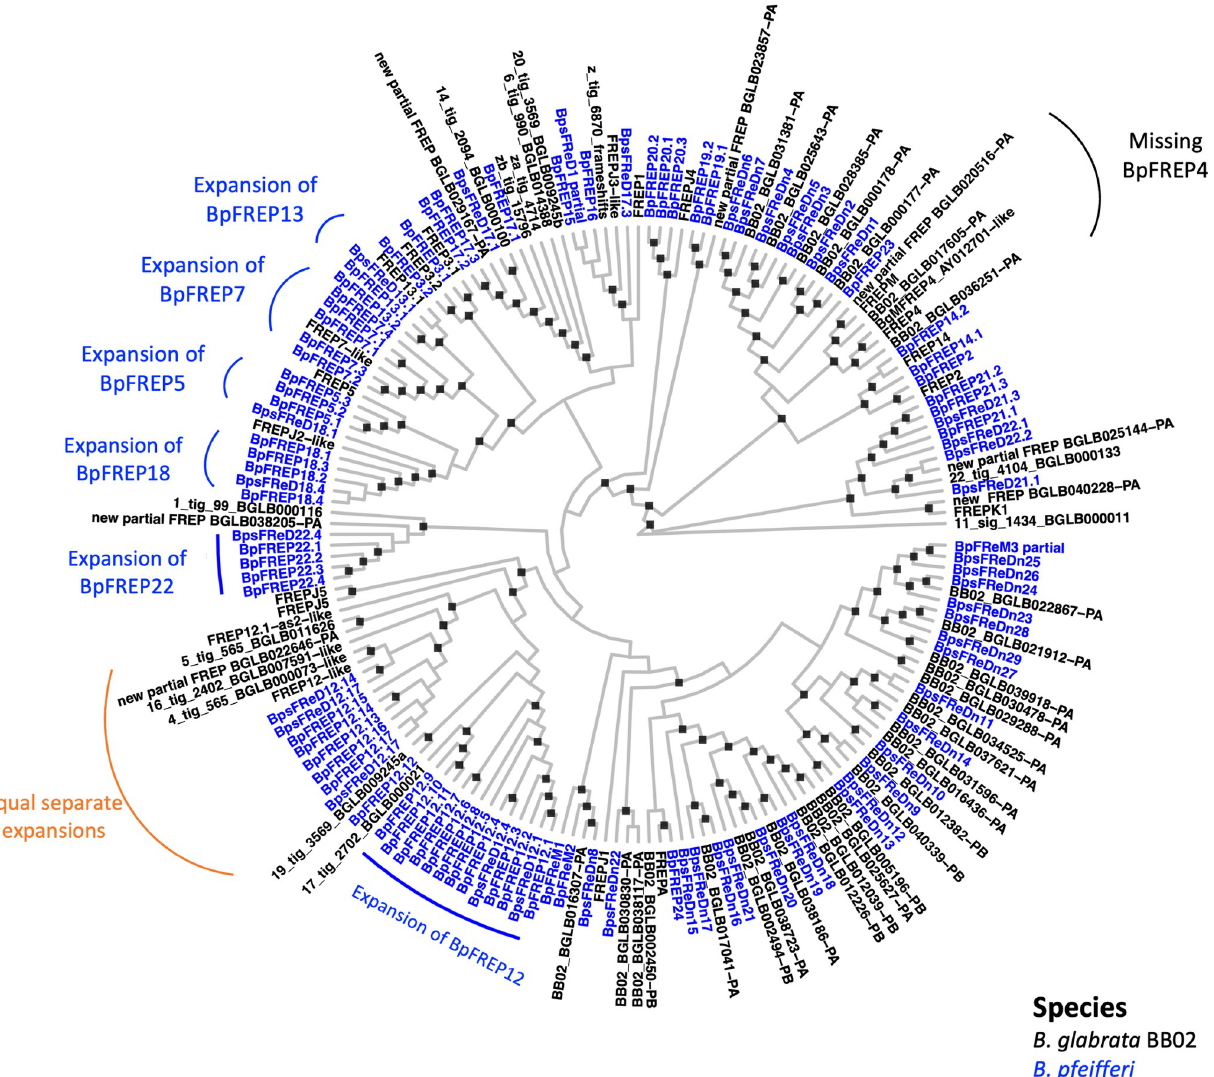
Fig 8. Maximum likelihood tree of FReDs from B . pfeifferi (blue) and B . glabrata BB02 (black). The ML tree with 1000 bootstrap replicates was constructed with full length FReDs protein sequences from B . pfeifferi (this study) and B . glabrata BB02. Bootstrap values equal or greater than 75% are represented by black squares on the internal nodes. For nomenclature of B . pfeifferi FReDs see descriptions in this study. Nomenclature of B . glabrata BB02 FReDs was described in previous studies [12,55,74,75,77,78]. The 3D structures of BpFREPs were predicted using the AlphaFold2 algorithm and visual- ized using VMD software (Fig 9). Key functional domains of BpFREPs and the start amino acid (1MET) are indicated in subfigure C. For BpFREP2, note the presence of a single IgSF domain and the relatively short interceding region (alpha helix) that brings the FBG domain close to the IgSF domain. BpFREP3.1 features two IgSF domains but has an interceding region that is truncated in length as compared to other FREPs. For BpFREP3.2, notice the long inter- ceding region more typical of two-IgSF domain containing FREPs. For comparison, Fig 9D shows the AlphaFold2 predicted structure for BgFREP3.2.